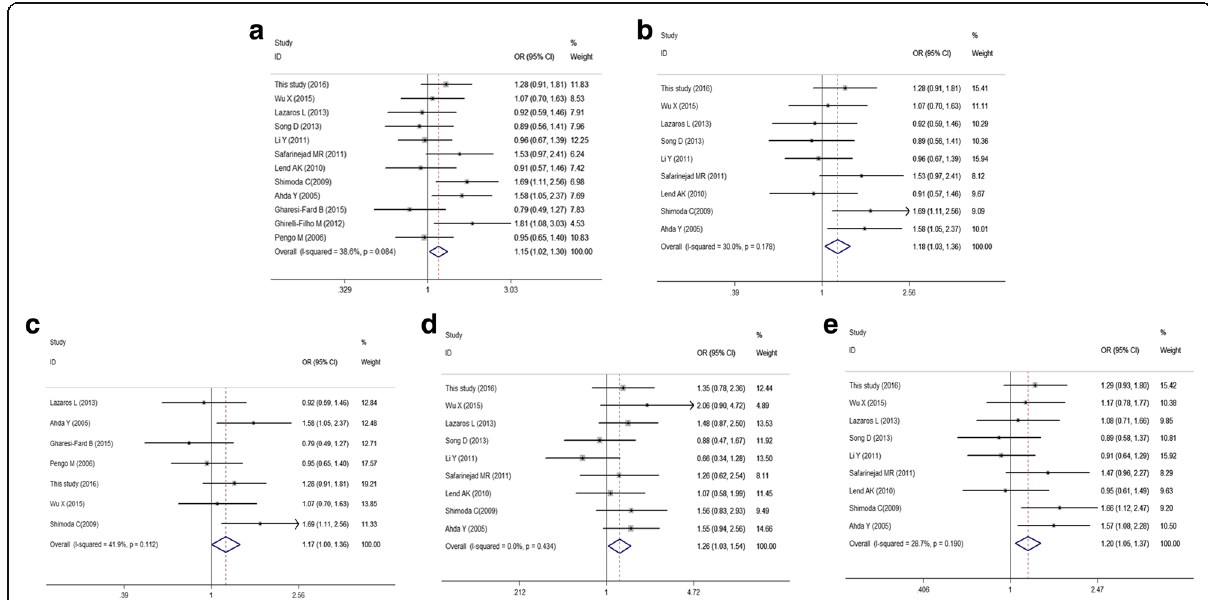
Fig. 2 Forest plot for the association between FSHR rs6165 and male infertility for fixed effects model. a AG vs. AA in overall analysis; ( b ) AG vs. AA in subgroup analysis of HWE > 0.05; ( c ) AG vs. AA in subgroup analysis of case count > 200; ( d ) GG vs. AA in subgroup analysis of HWE > 0.05; ( e ) GG + AG vs. AA in subgroup analysis of HWE > 0.05. For each study, the point estimate of OR (the size of the square is proportional to the weight of each study) and 95% CI for OR (extending lines) is shown. Pool OR and 95%CI are presented as